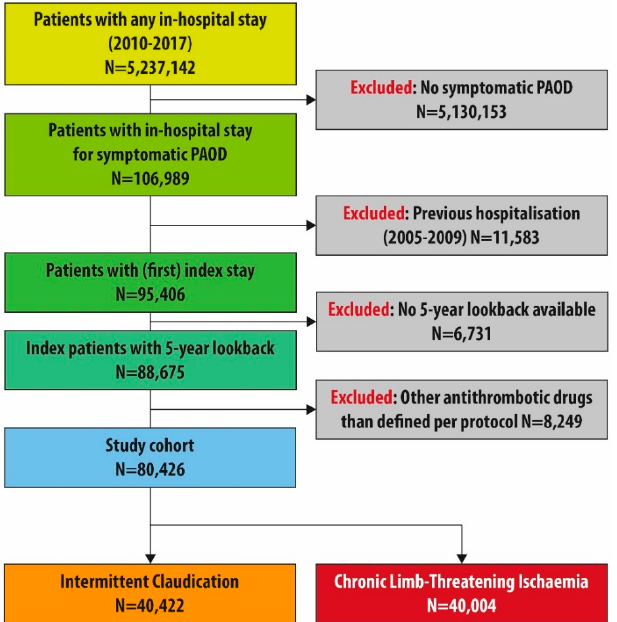
Figure 1. Flow chart of the study cohort, PAOD: Peripheral arterial occlusive disease.